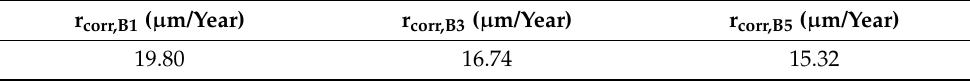
Table 28. Normative corrosivity estimation based on calculated first-year corrosion loses.